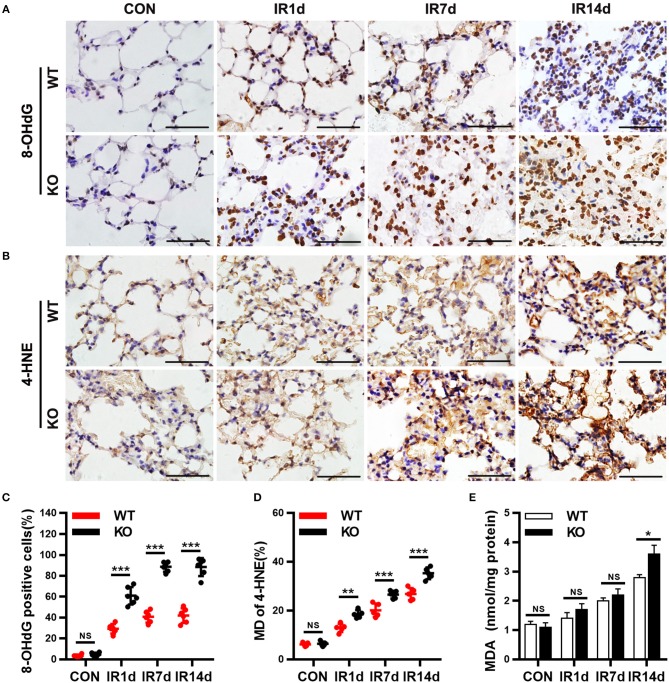
Nrf2 knockout worsens radiation-induced oxidative damage of lung tissues. (A,C) Nrf2 deficiency increased radiation induced 8-OHdG (a biomarker of DNA peroxidation product) positive cells in lung tissues. (B,D) Loss of Nrf2 increased 4-HNE (a biomarker of lipid peroxidation product) positive cells in lung tissues. (E) Nrf2 knockout upregulated the levels of MDA, another biomarker of lipid peroxidation product, in lung tissues. Scale bar: 50 μm. n = 6. NSRepresents no statistical difference (P > 0.05). *P < 0.05; **P < 0.01; ***P < 0.001. Every experiment was repeated for 3 times. The data was shown as mean ± SD, and the representative figures were presented here.